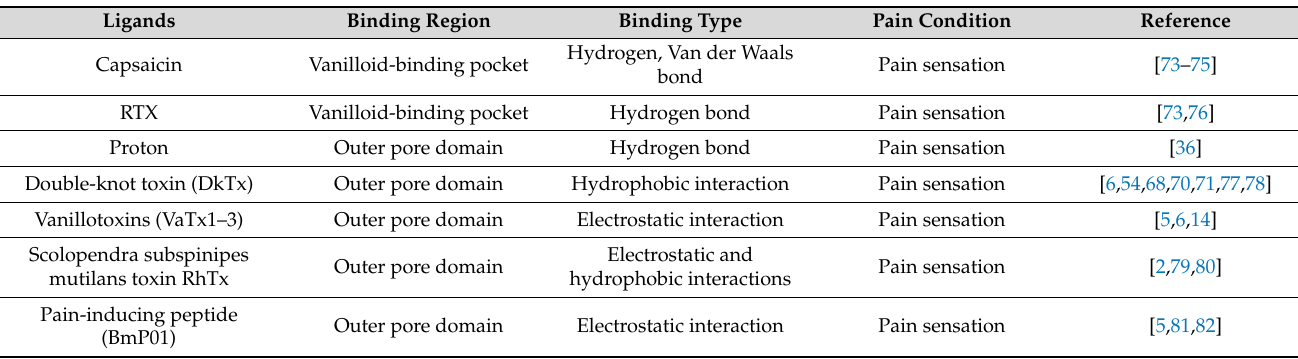
Table 1. Various ligands and venom peptides (activators/inhibitors) of the transient receptor potential vanilloid 1 (TRPV1)